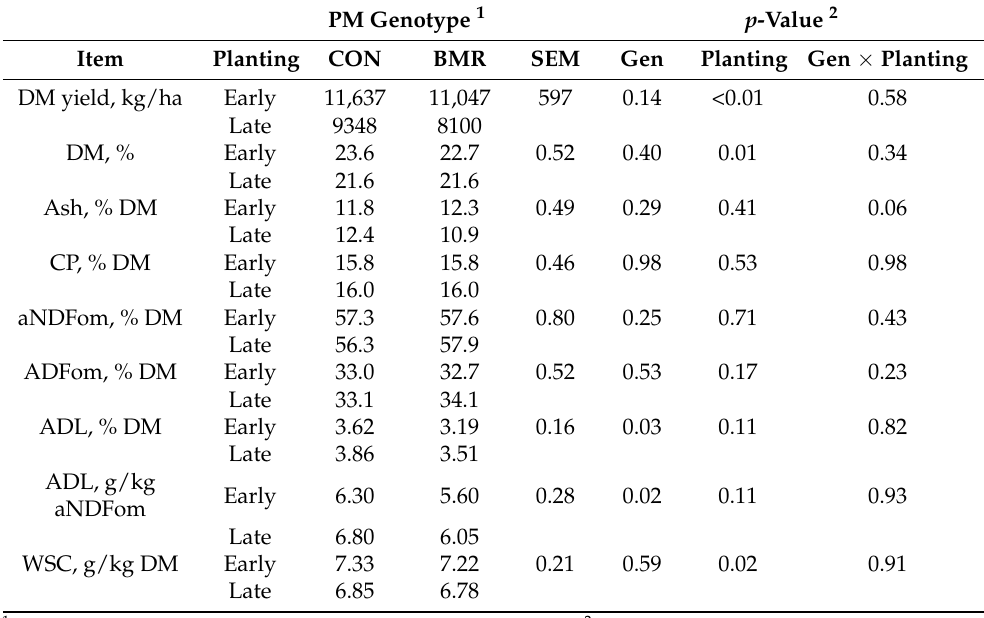
Table 1. Yield and nutritional composition of pearl millet genotypes planted at different dates (Trial 1). PM Genotype 1 p -Value 2 Item Planting CON BMR SEM Gen Planting Gen × Planting DM yield, kg/ha